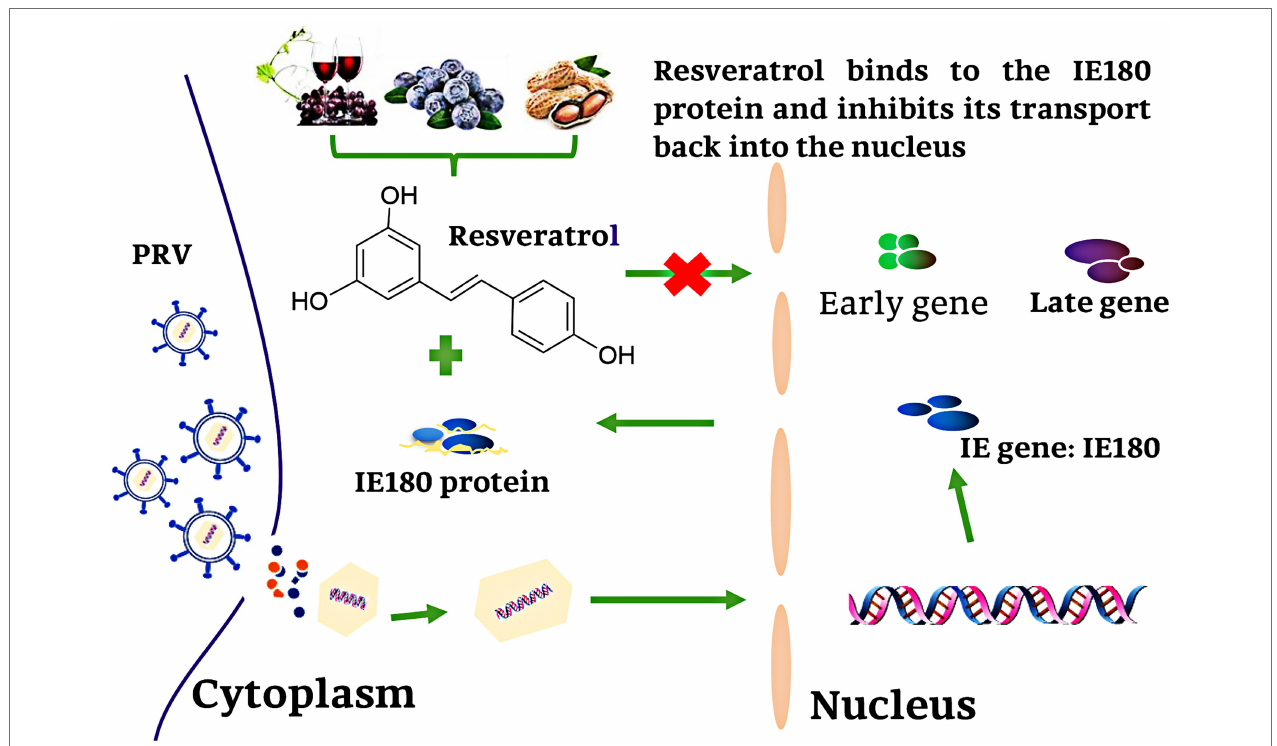
FIGURE 9 | Schematic presentation of possible the Res anti-PRV molecular mechanism. Res binds to the amino acid of IE180 protein (Thr601, Ser603, and Pro606), thus affecting its transcriptional activation function, leading to the blocked downstream gene